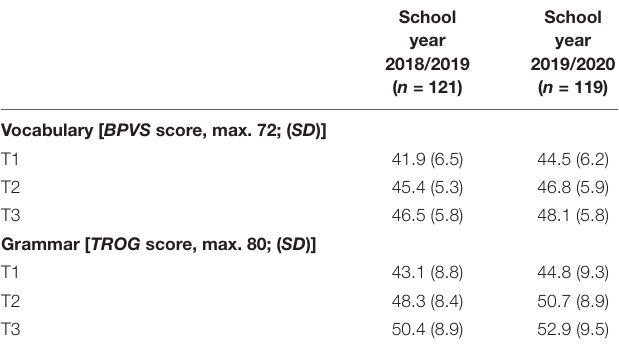
TABLE 2 | English vocabulary scores (BPVS) and grammar scores (TROG) by Testing Session and Group.